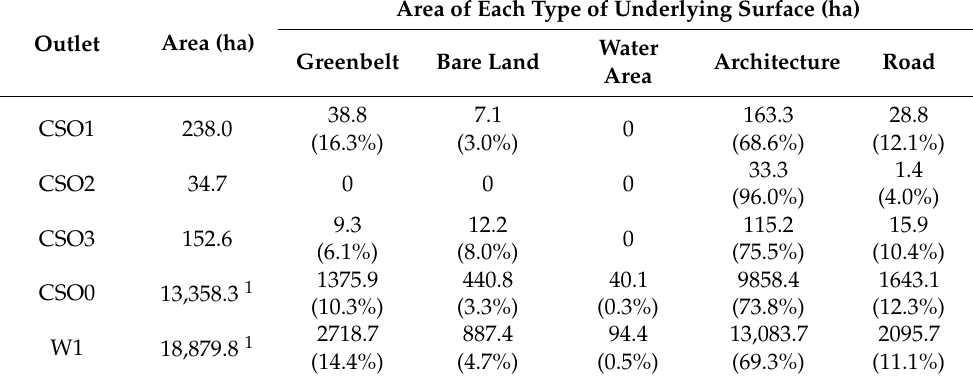
Table 1. Information of catchment area corresponding to each monitoring point. Area of Each Type of Underlying Surface (ha) Outlet Area (ha) Water Architecture Greenbelt Bare Land Area